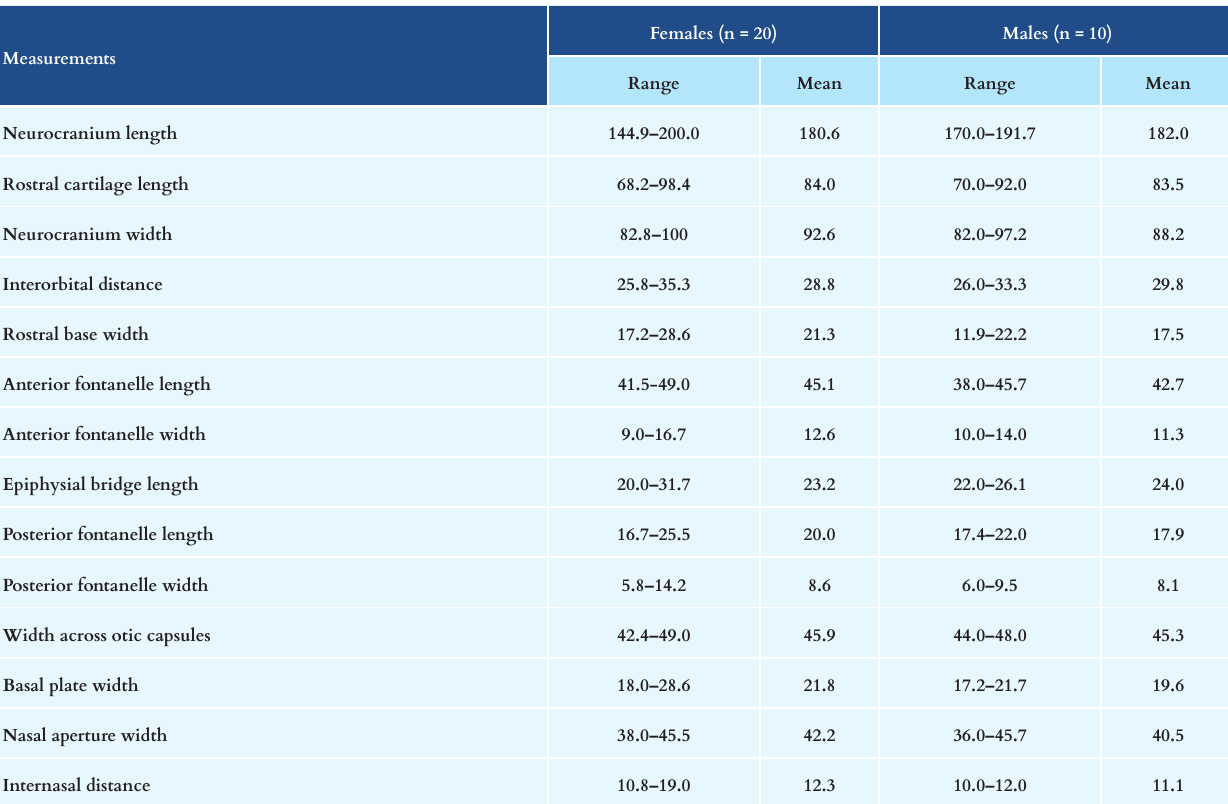
TABLE 5 | Neurocranial measurements in percentages of nasobasal length (% NL) of male and female specimens of Atlantoraja cyclophora .